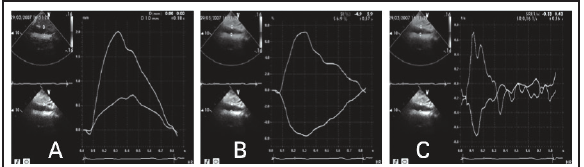
Figure 1. Measurement methods of tissue tracking and strain rate imaging. The image was obtained from the long-axis view of the abdominal aorta. A. peak displacement determined by aortic displace- ment curve; B. peak strain determined by aortic strain curve; C. peak strain rate determined by aortic strain rate curve.